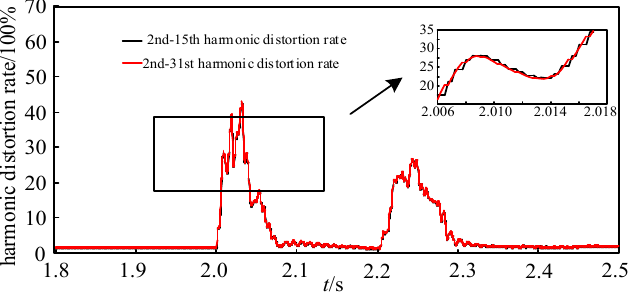
Figure 8. Harmonic voltage distortion rate under fault.